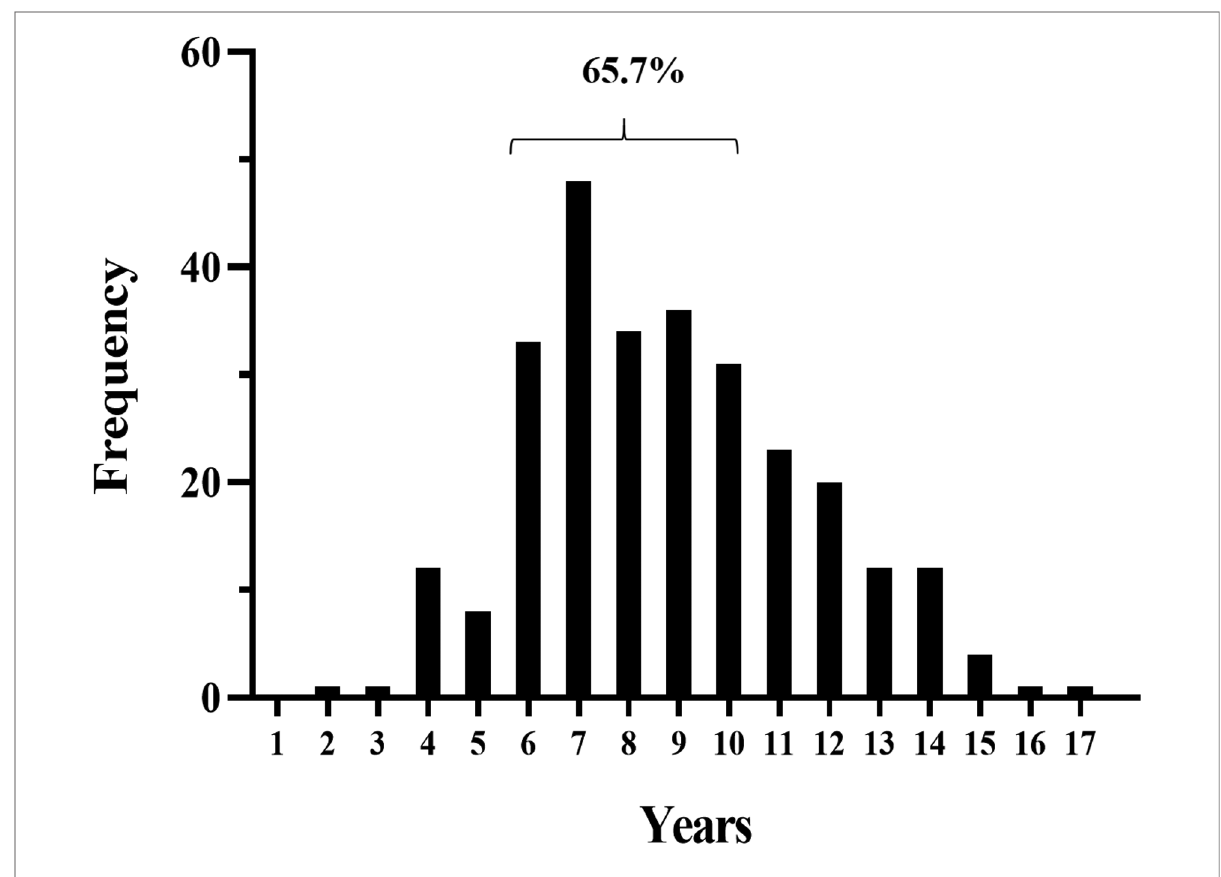
FIGURE 2 Age distribution of the included children.